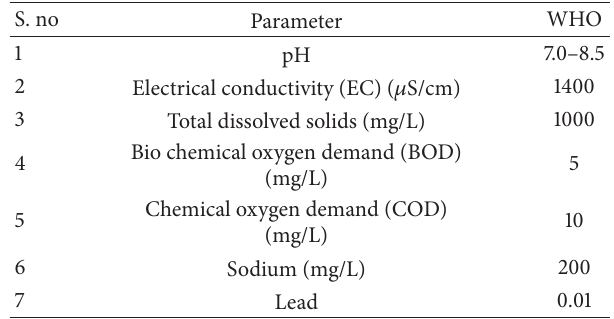
Table 4: Water quality parameters with respect to the WHO